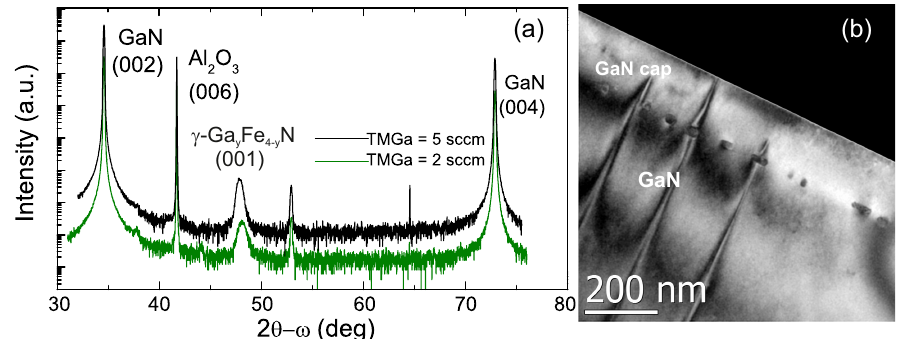
Figure 8. Secondary phases in Ga δ FeN layers identified from: ( a ) high-resolution XRD (HRXRD), and ( b ) cross-section TEM showing the planar γ ’-Ga y Fe 4 − y N nanocrystal arrays. Adapted from Reference